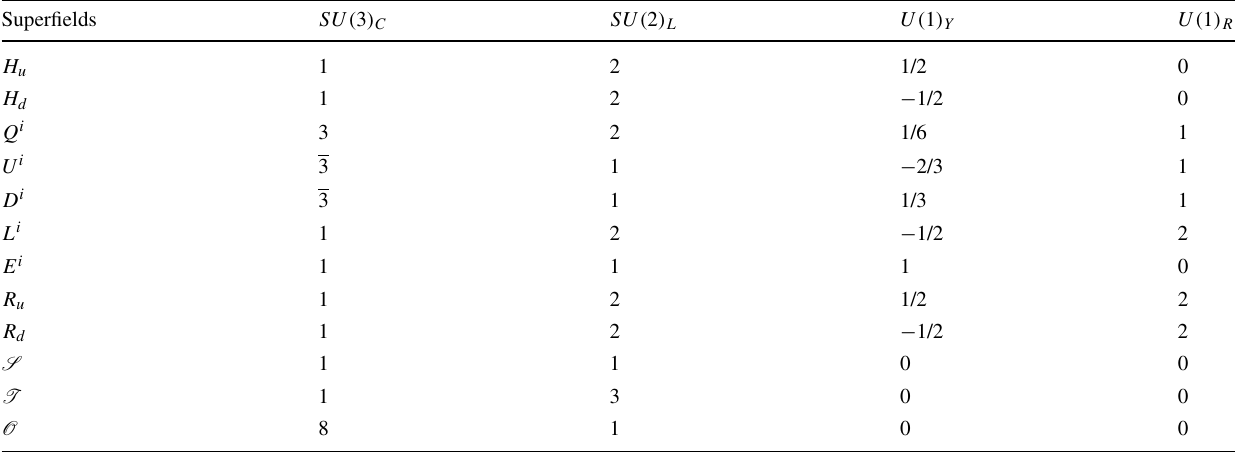
Table 28 MSSM + Global U ( 1 ) R : Quantum numbers of superfields under the gauge groups. Internal symmetry indices have been suppressed. i = 1 , 2 ,.., N f is the flavour index